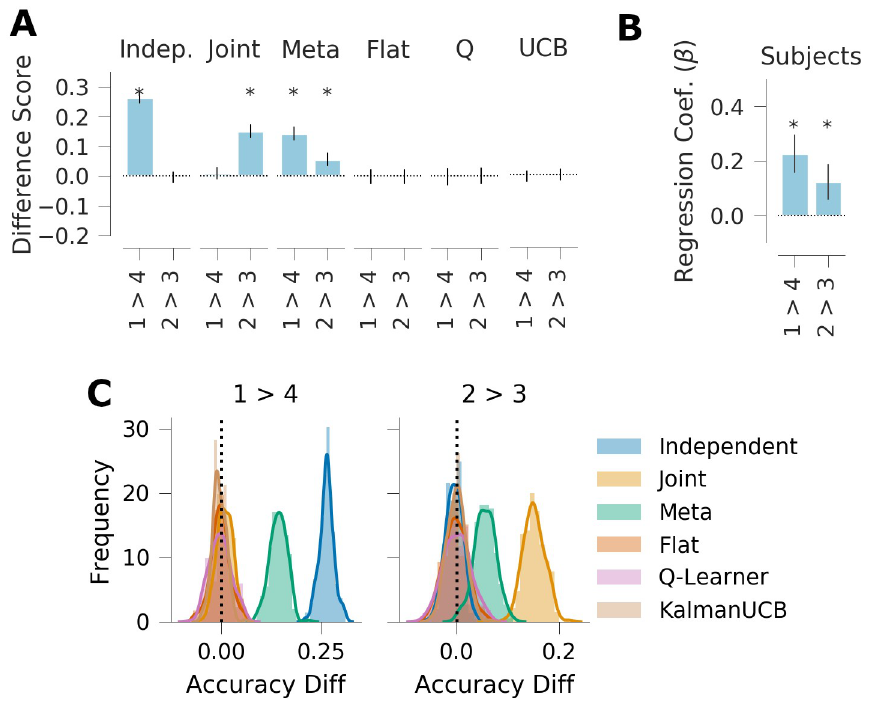
Fig 9. Generalization performance in experiment 3. A : Qualitative model predictions expressed as the difference scores Context 1—Context 4 and Context 2—Context 3 . B : Human subject data. Regression weights for the two within- subjects comparisons. C : Histogram of simulated effect sizes in the two comparisons of interest for each of the 6 evaluated models. Error bars denote standard